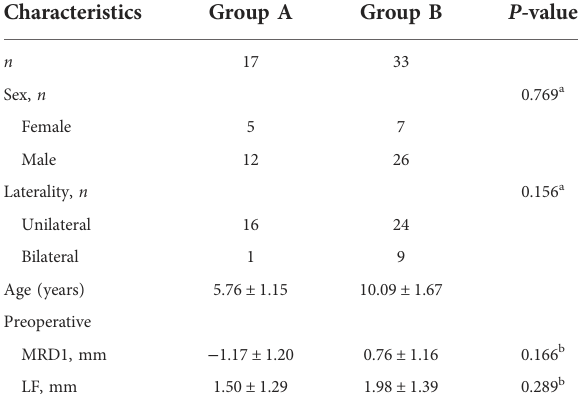
TABLE 1 Preoperative patient